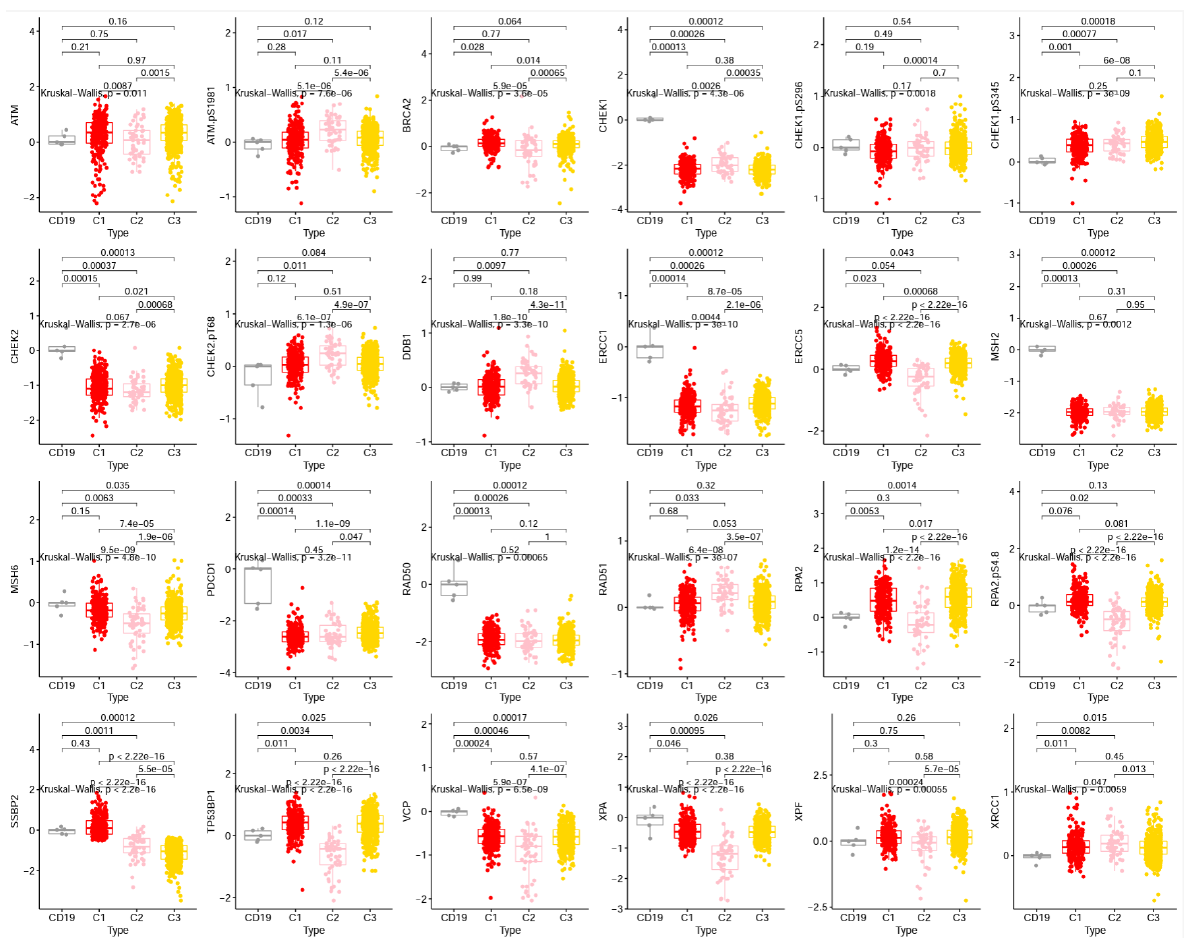
Figure 2. Expression of DDR proteins within and between clusters, relative to normal B-lymphocytes. The boxplot for each of the 24 DDR proteins analyzed in normal CD19+ lymphocytes (Gray) and the three DDR clusters (1 is red, 2 is pink, and 3 is yellow) is shown, along with p -values for each possible comparison.